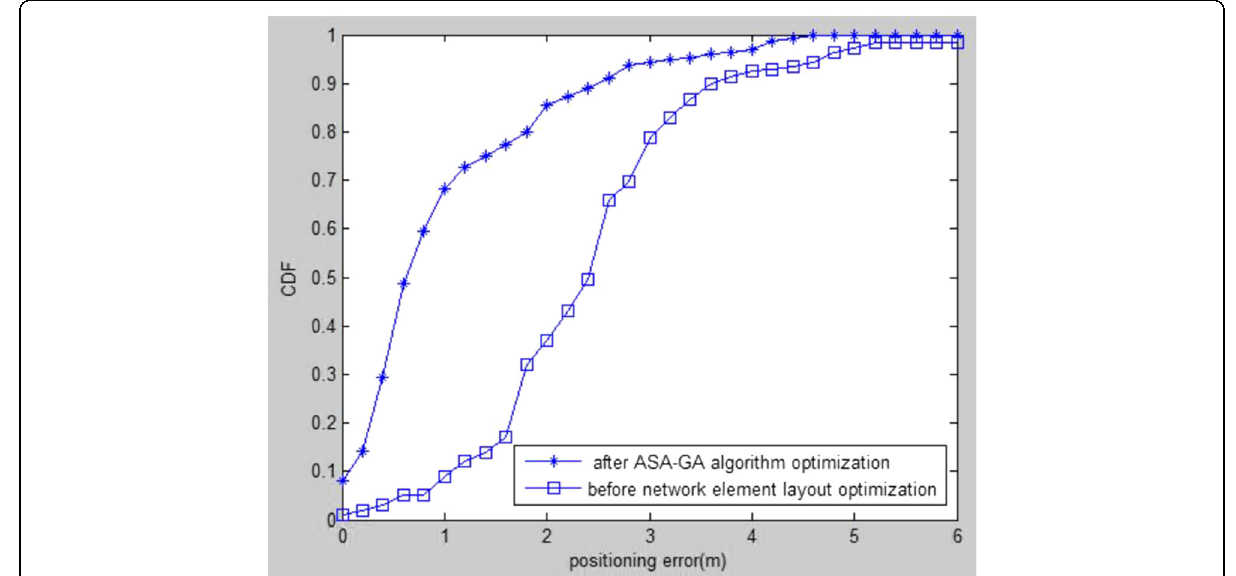
Fig. 4 Error accumulation distribution diagram before and after optimization of network elements layout. The curve with squares represents before network element layout optimization and the curve with stars represents after ASA-GA algorithm